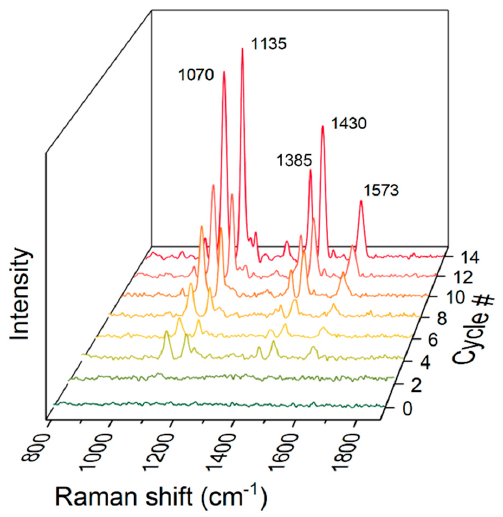
Figure 6. SERS spectra showing an increment in each peak of 4-ATP (12.5 ppm) with increasing number of LbL cycles.